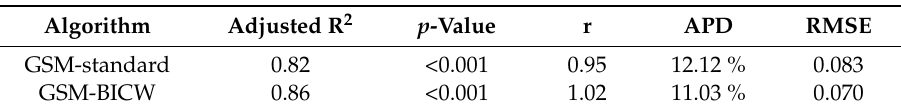
Table 6. Regression indices and statistical indicators computed based on the previous chl-a match-up analyses (Figure